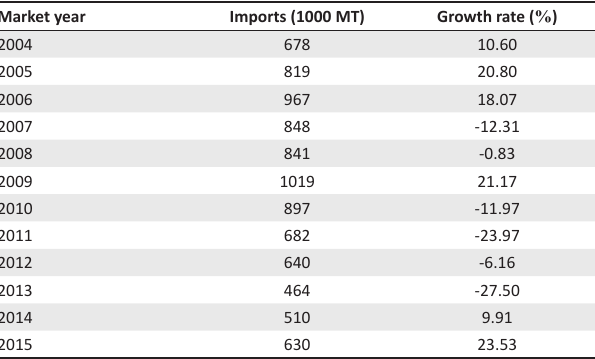
TABLE 6: Wheat imports by South Africa from 1997 to